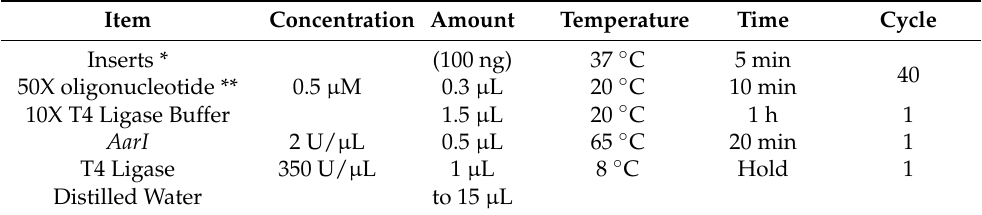
Table 10. Components of Golden Gate reaction and thermal conditions.